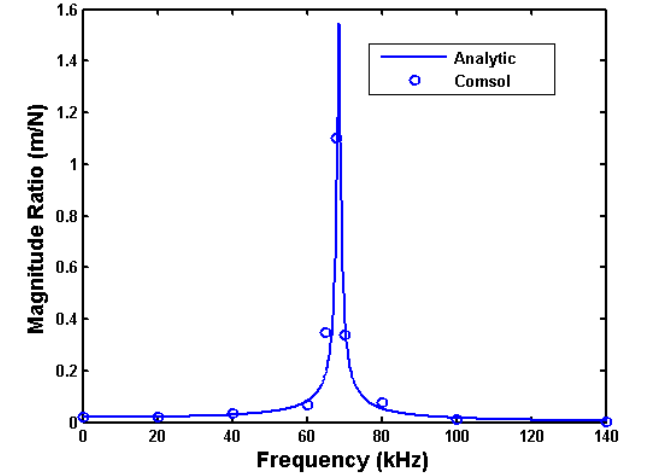
Figure 7. Comparison of analytical and numerical frequency responses for square plate with 5 μ m × 5 μ m hole, at ambient pressure of 300 Pa, with folded leg stiffness of 51.65 N/m.